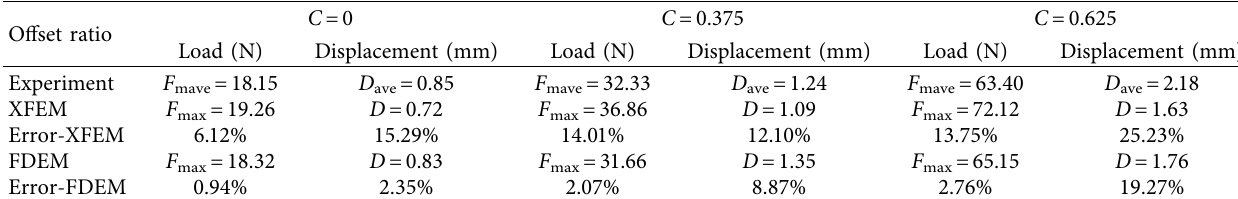
Table 4: Comparison of XFEM and FDEM with the experimental